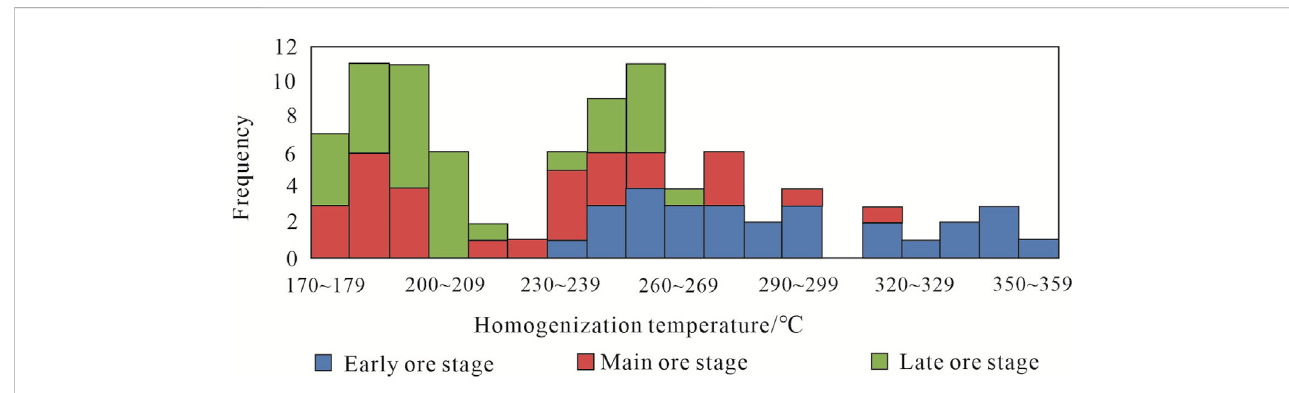
FIGURE 8 Homogenization temperature histogram of fl uid inclusions from the different metallogenic stages at